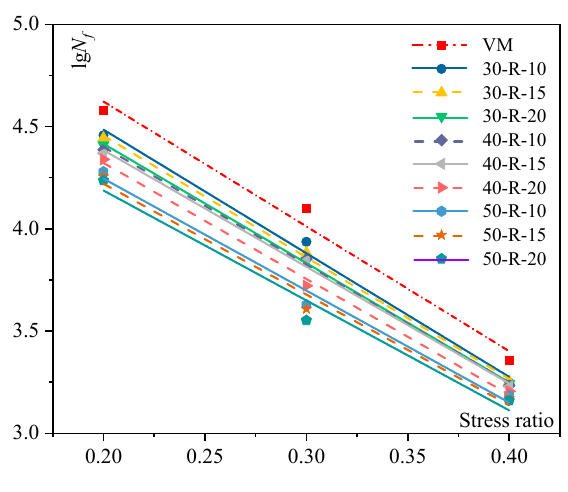
Figure 5. Fatigue life at different stress ratios. Table 11. Regression parameter between the logarithm of fatigue life and different stress ratios. Parameters